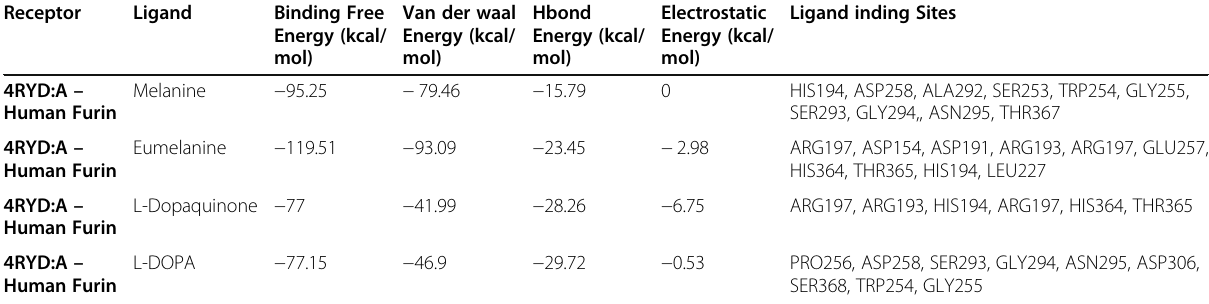
Table 2 Determination of binding free energy of docking interactions between melanine, eumelanine, l-dopaquinone and l-dopa with human furin (4RYD) using iGEMDOCK